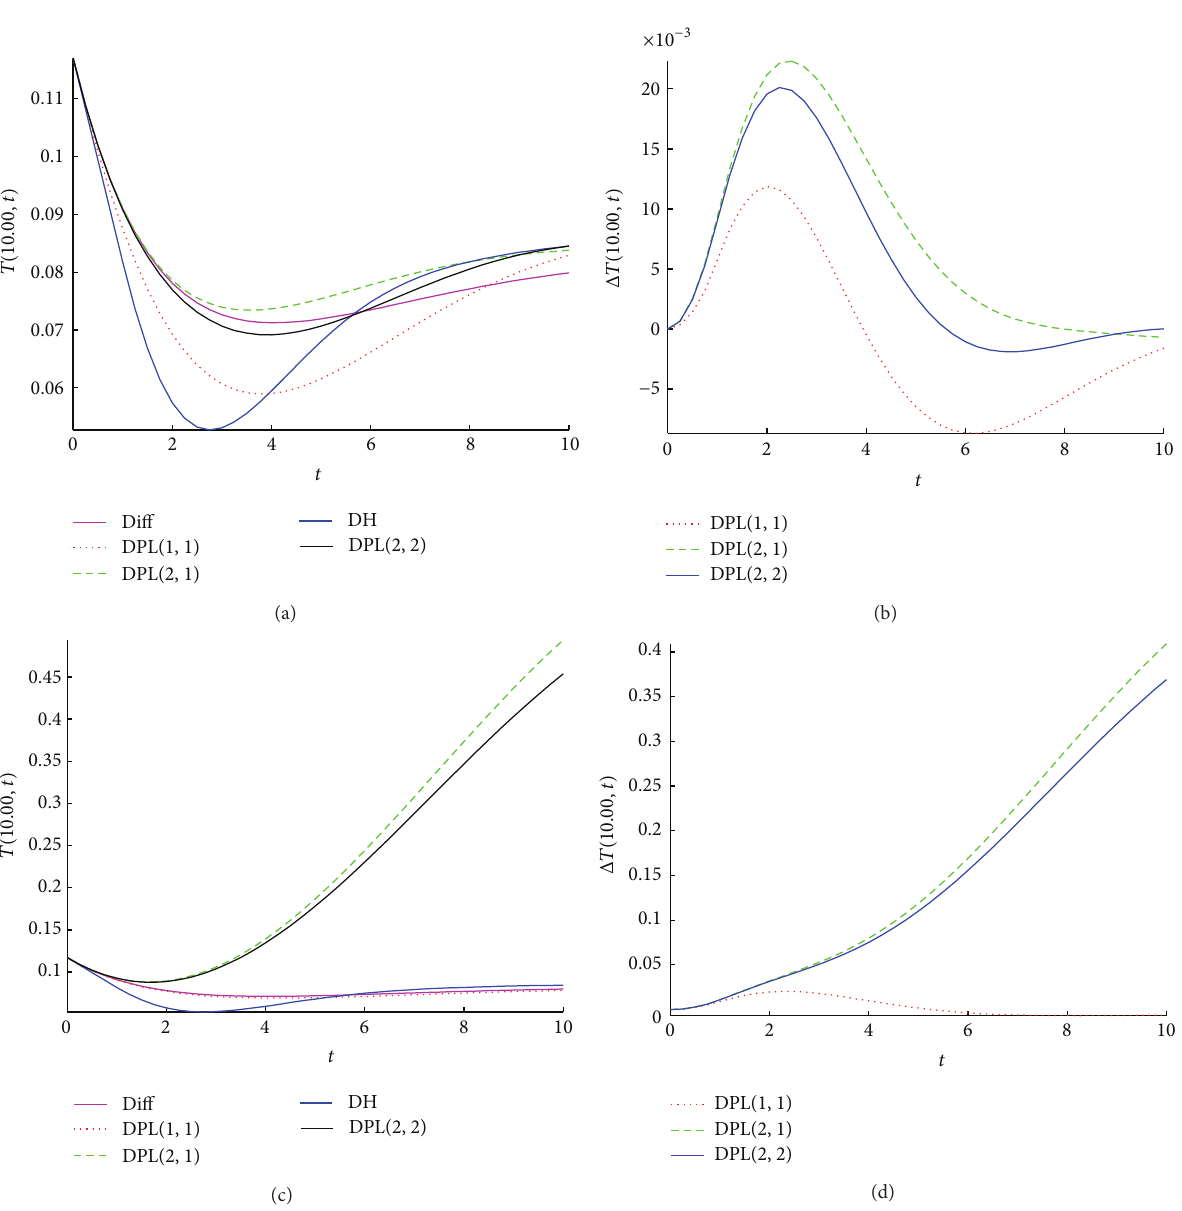
Figure 4: Temperature evolution for DPL, DH, and classical diffusion (Diff) models (left), and differences from DH of DPL approximations (right), at 𝑥 = 10 , with Dirichlet boundary conditions, initial function 𝜑(𝑥,𝑡) = 2(1 − cos (𝑥))/(𝜋𝑥) , and parameters 𝛼 = 0.8 , 𝜏 𝑇 = 1 , and = 1 (top), or 𝜏 = 19 and 𝜏 = 20 𝜏 𝑞 𝑇 𝑞